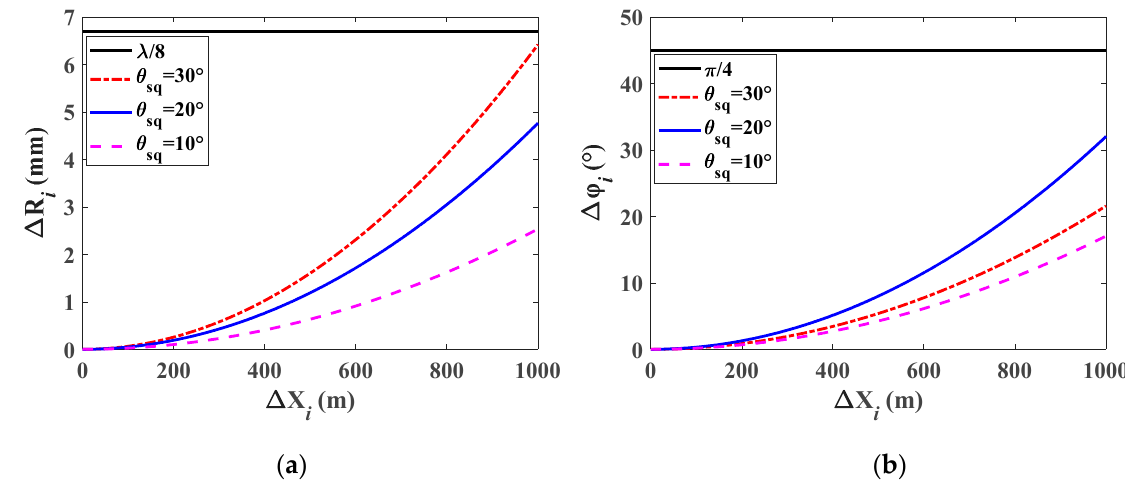
Remote Sens. 2021 , 13 , x FOR PEER REVIEW Figure 3. Analysis of the time-varying term. ( a ) The time-varying slant range error ∆ R i produced by ∆ x i in different θ sq ; ( b ) the time-varying phase error ∆ ϕ i produced by ∆ x i in different θ sq .